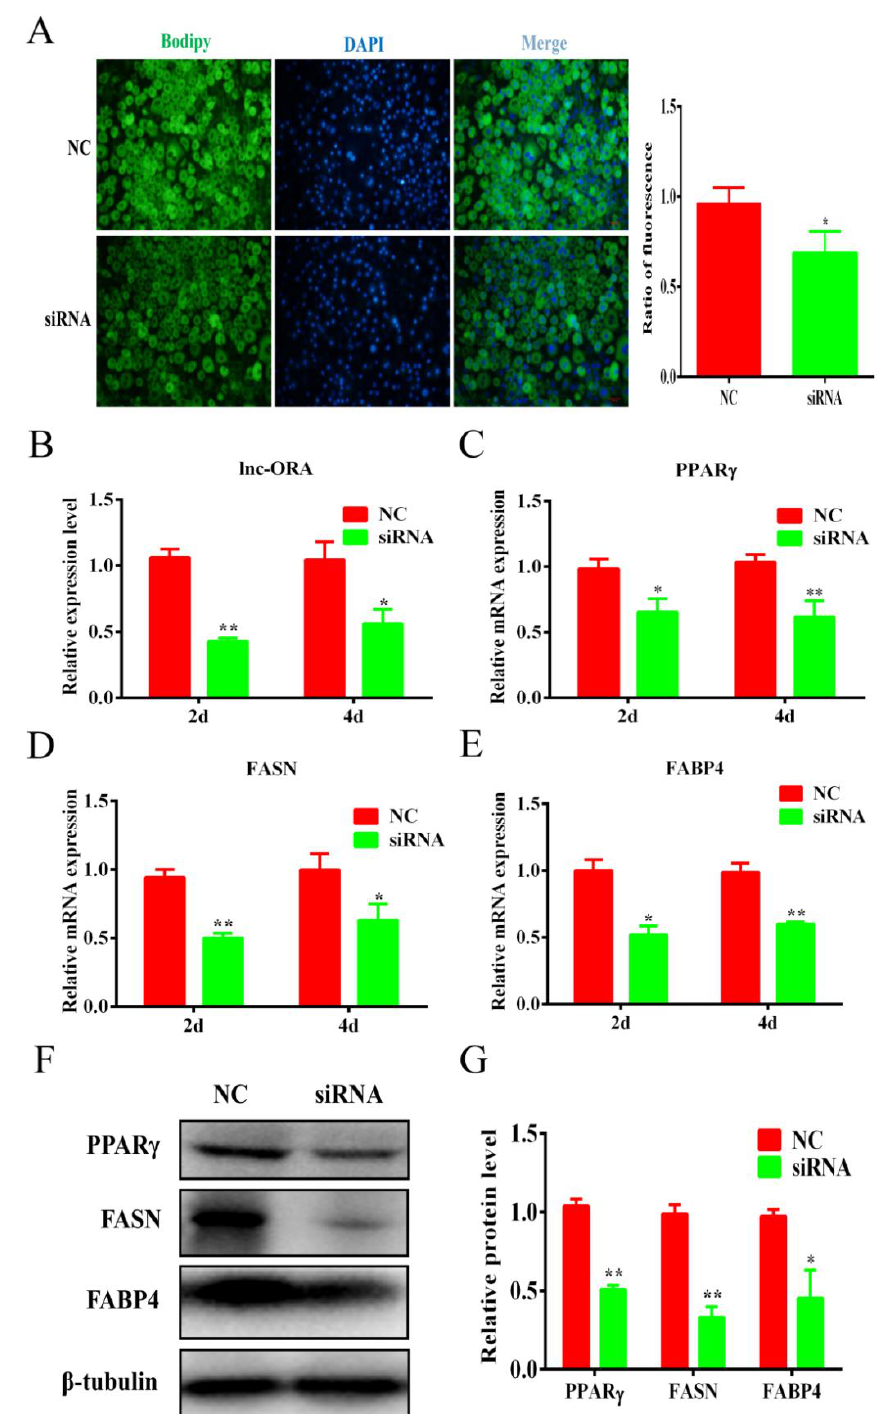
Figure 8. Knockdown of lnc-ORA inhibits adipocytes differentiation. ( A ) BODIPY staining of adipocytes after induction for 6 d. ( B ) Knockdown efficiency of lnc-ORA after adipocyte transfection for 2 d and 4 d. ( C – E ) mRNA levels of adipocytes markers, including PPAR γ , FASN , and FABP4, after adipocyte transfection for 2 d and 4 d. ( F ) Protein levels of adipocyte-specific genes, including PPAR γ , FASN, and FABP4, analyzed by Western blot. ( G ) Protein quantification analysis by Western blot. Data are expressed as the mean ± SEM (n = 3). * p < 0.05, ** p < 0.01, vs. NC.